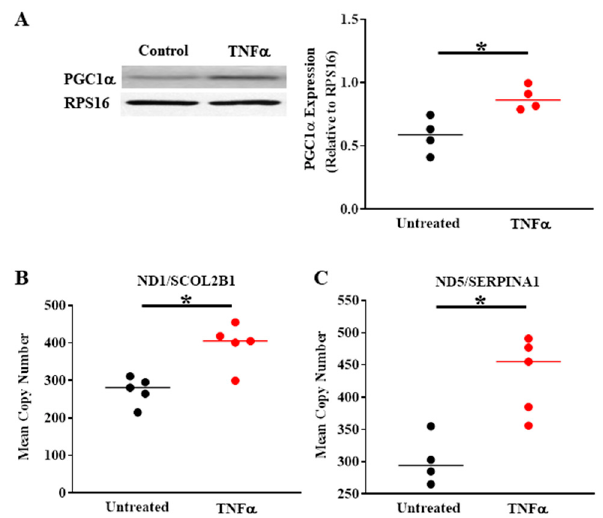
Figure 3. Compared to untreated controls, TNF α (20 ng/mL, 24 h) increases PGC1 α protein ex- pression in human ASM ( A ) and mitochondrial DNA copy number ( B , C ), indicating an increase in mitochondrial biogenesis. (* denotes a significant difference between TNF α treated and untreated control groups; p < 0.05; t-test; cells were dissociated from ASM samples from n = 5 patients and divided into TNF α treated and untreated control groups). All data are presented as scatter plots with the lines indicating the mean values. These figures are modified from presentations of previously reported results [4].